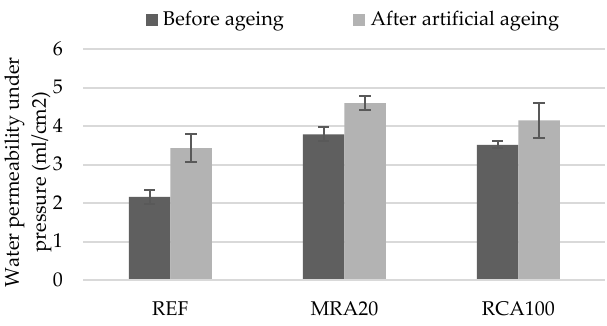
Figure 14. Water permeability under pressure of the mortars tested.